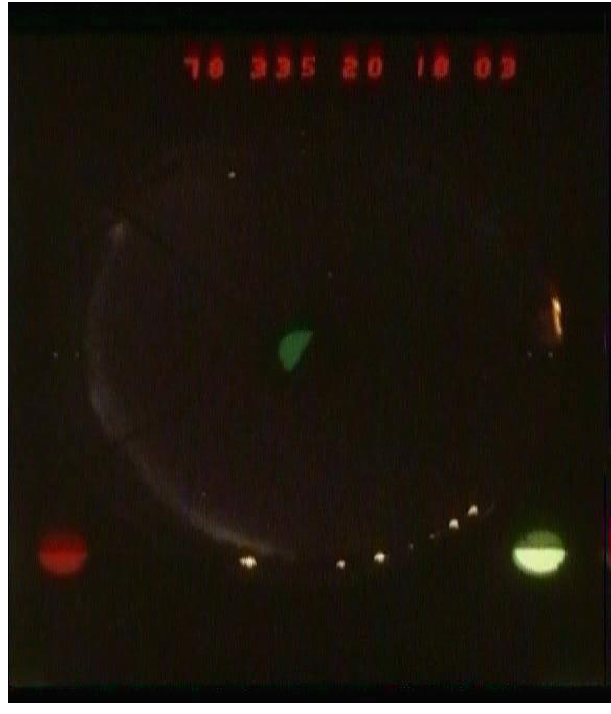
Table 1. List of film camera stations together with their years